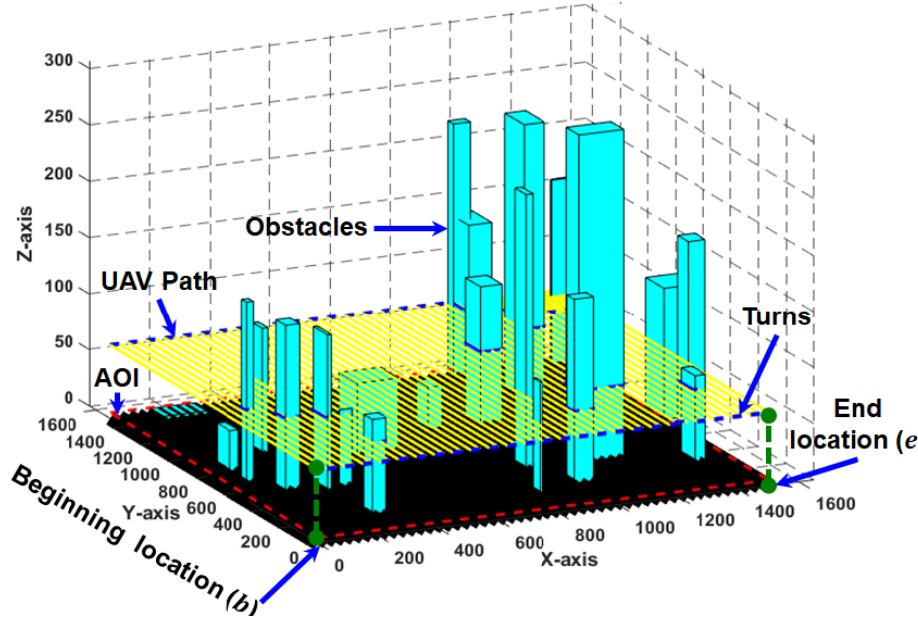
Figure 12. Path (i.e., the yellow line) from the square-shaped AOI located in an urban